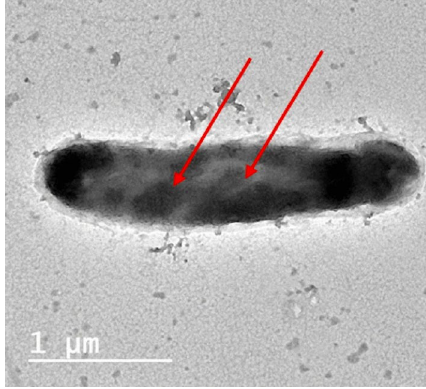
Fig. 3 TEM image of the cells grown in the presence of Cr (VI) (Abo‑Alkasem et al.